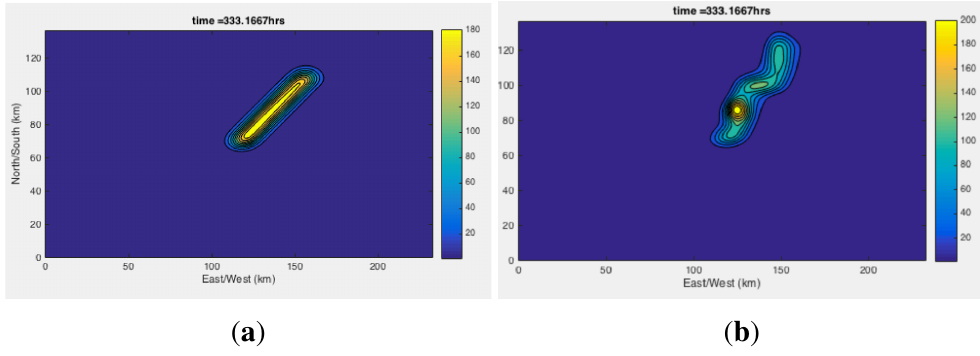
Figure 17. Summer conditions. Final configuration of tracer due to a point source located in the center of the domain, after about 333 h. ( a ) Steady current, no Stokes drift velocity; ( b ) steady currents and Stokes drift.